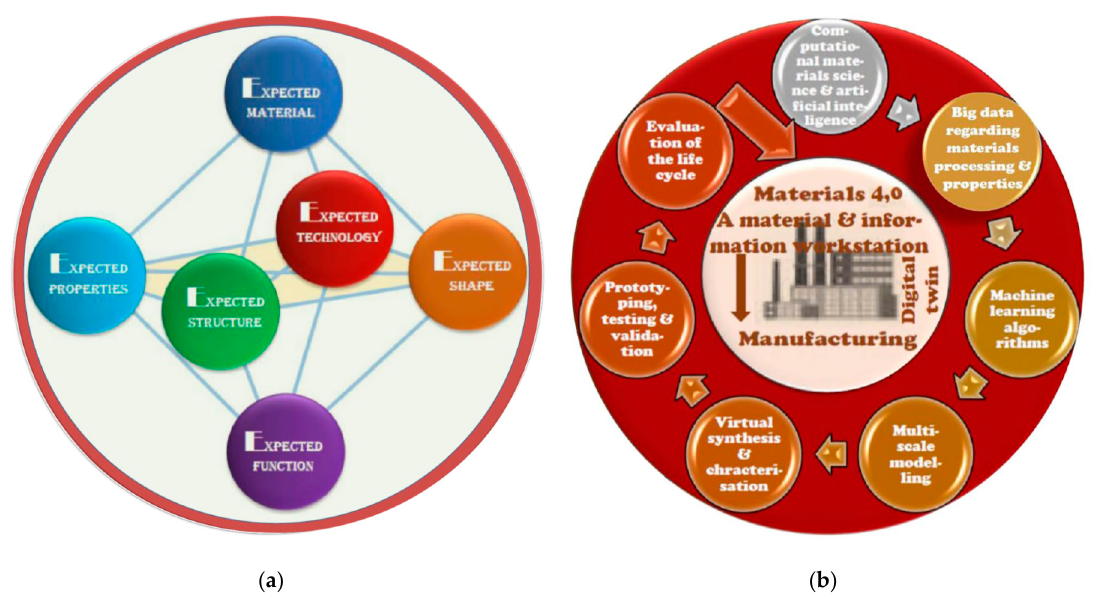
Figure 19. Schematic of the extended holistic Industry 4.0 model.